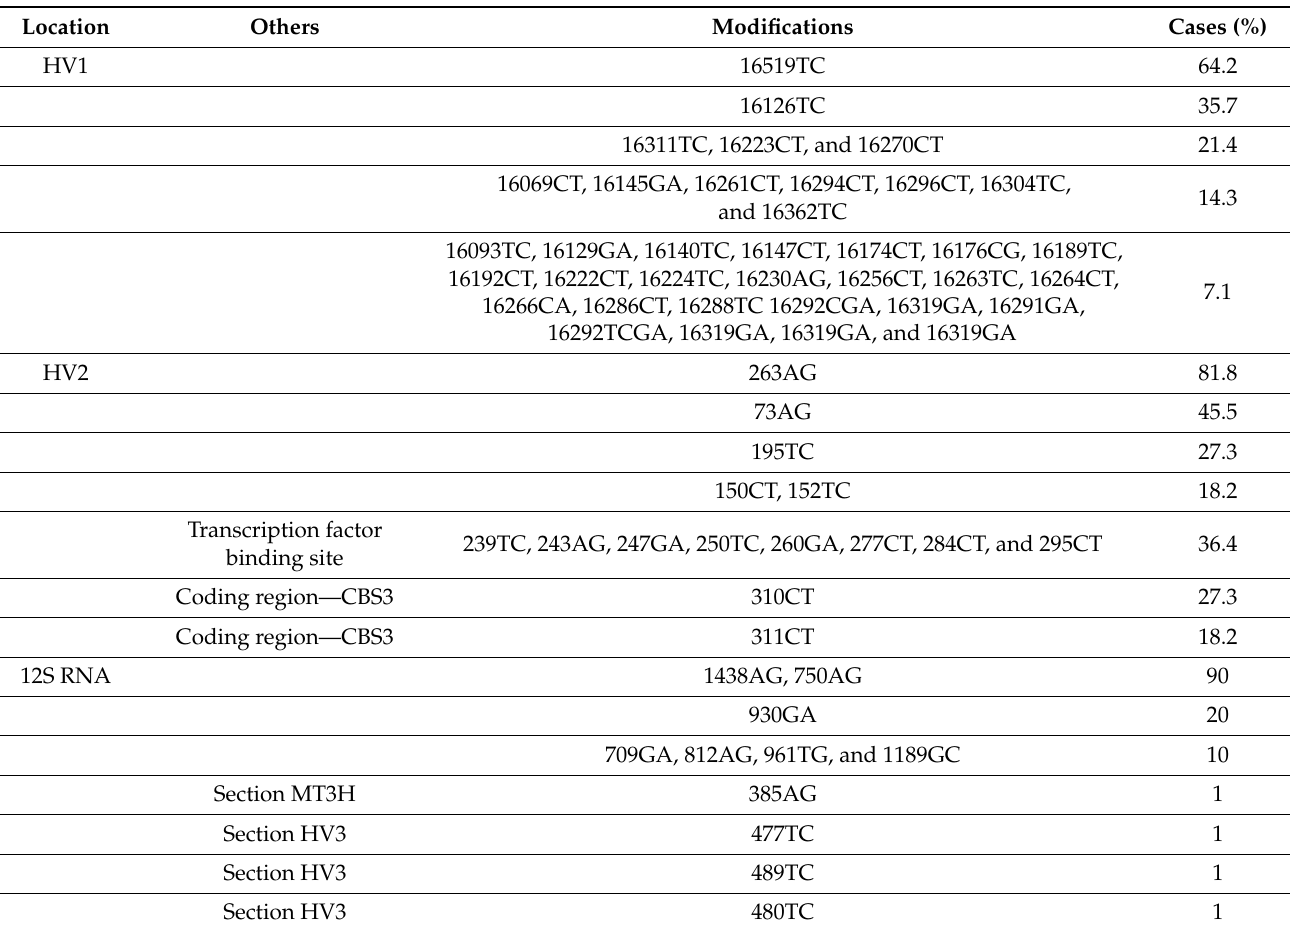
Table 2. Distribution of nucleotide changes in HV1, HV2, and 12S RNA regions of mtDNA of all patients.